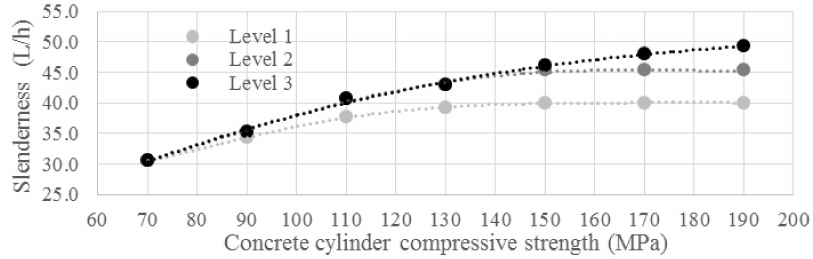
Achievable slenderness of a box girder bridge with an increasing concrete compressive